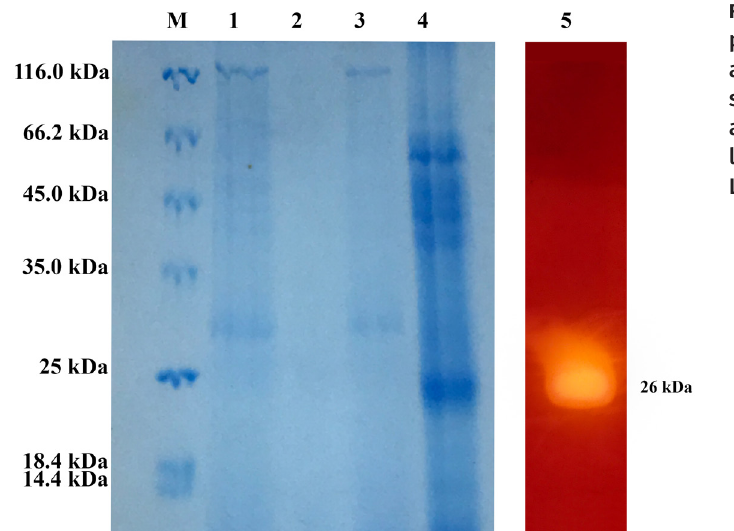
Figure 5. Comparition of total proteins of recombinant and non-recombinant strains on SDS-PAGE (1-4) and zymogram analysis of lichenase enzyme on SDS- Lichenan-PAGE